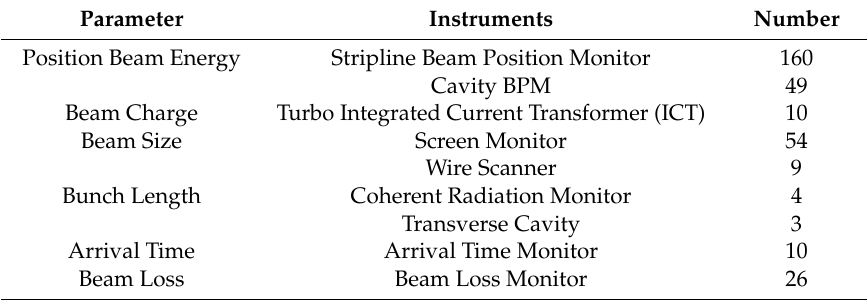
Table 3. Major components of beam diagnostics and their